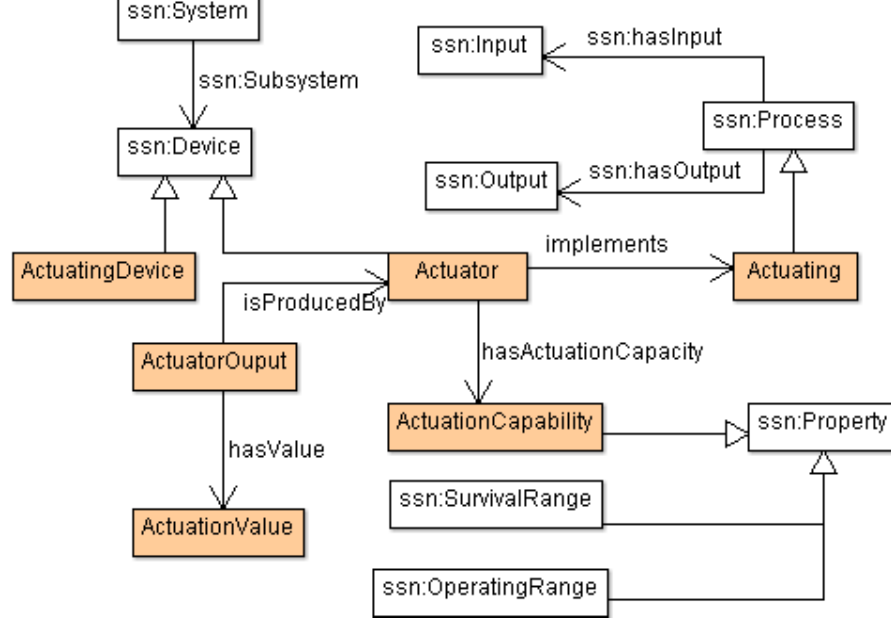
Figure 6. SSN extension introducing concepts related to the actuator conceptualization.